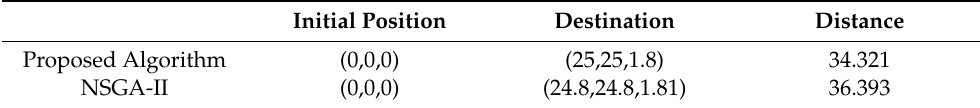
Table 2. Flight Details of proposed algorithm and NSGA-II.